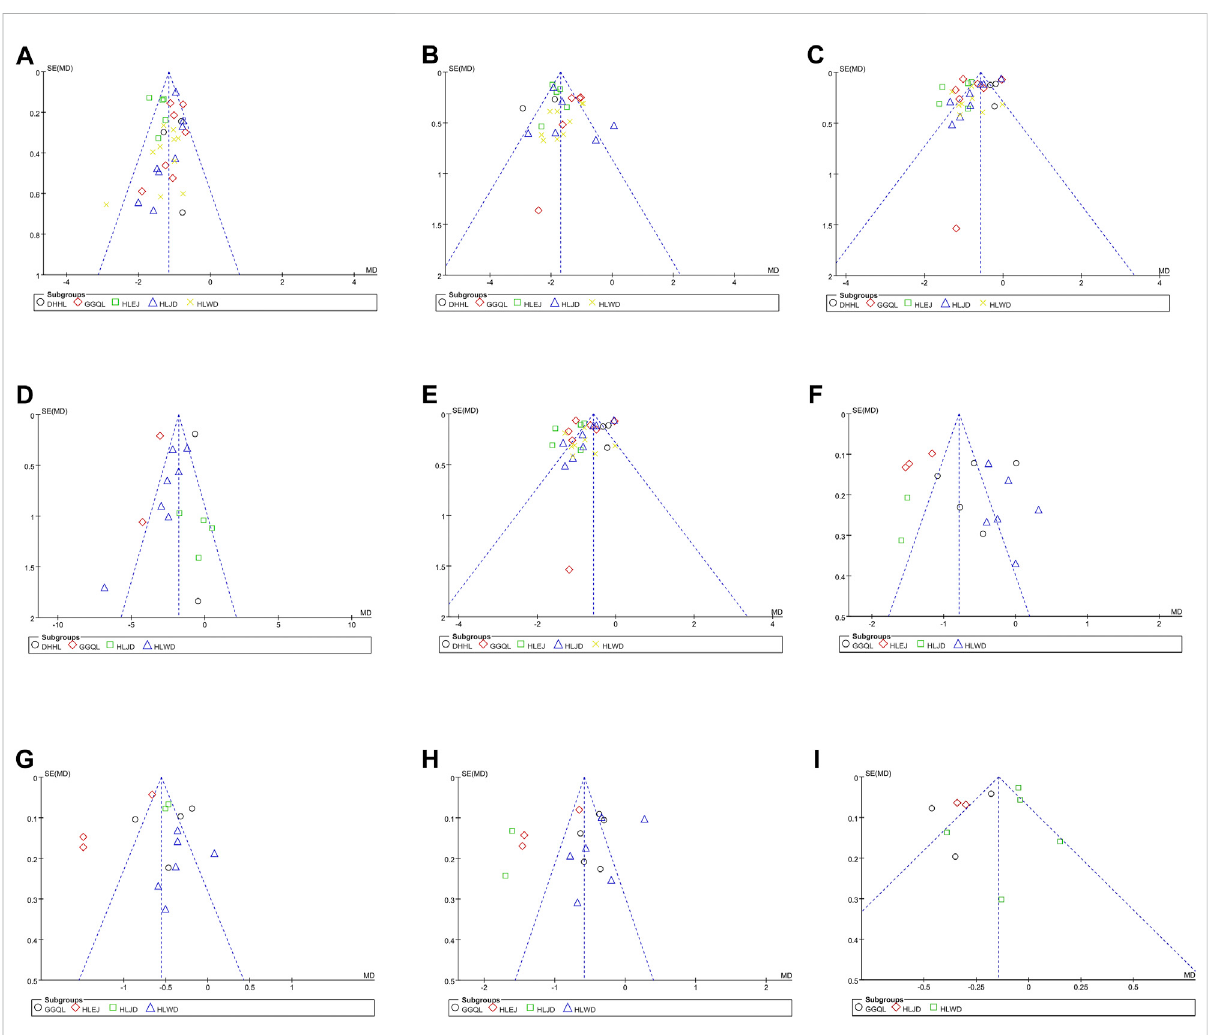
FIGURE 5 Funnel plots of the trials that compared HLPs plus metformin with metformin. Note: (A) Represents FBG; (B) Represents 2hPG; (C) Represents HbA1c; (D) Represents FINS; (E) Represents HOMA-IR; (F) Represents TC; (G) Represents TG; (H) Represents LDL-c; (I) Represents HDL-c.